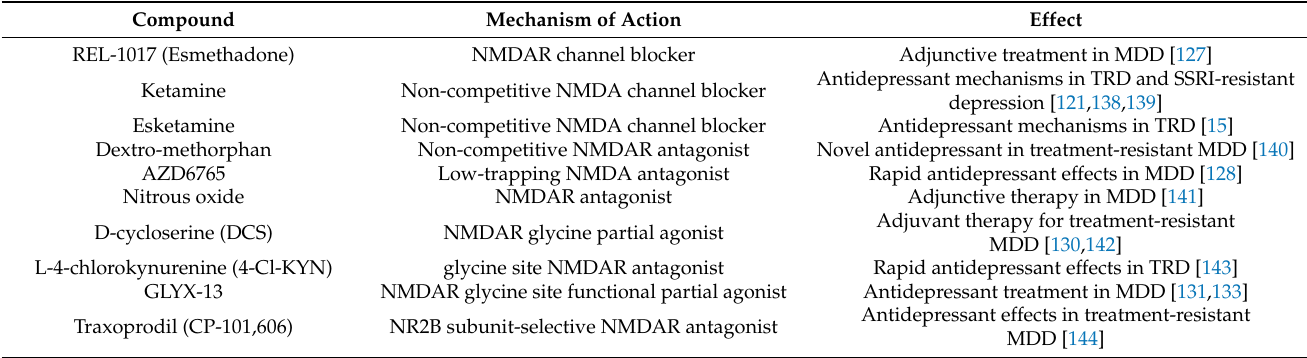
Table 2. Novel NMDARs modulators in clinical trials for